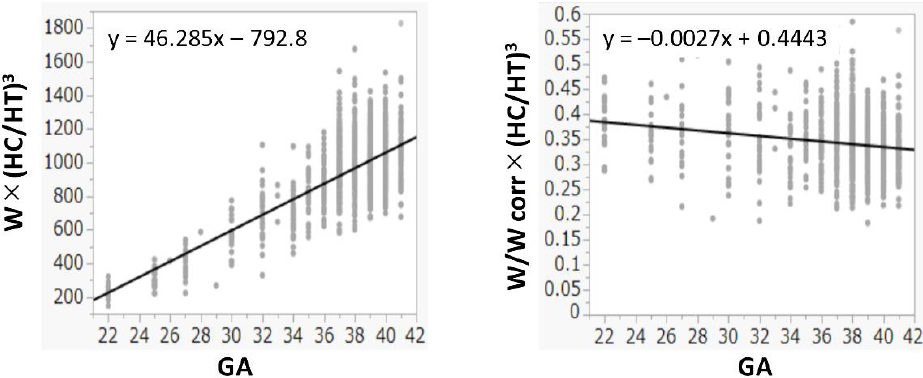
Figure 2. Physique index corrected by birth weight or birth weight corrected by mean weight for gestational age at birth. GA: gestational age at birth; HC: head circumference; HT: height; W: birth weight; Wcorr: mean weight for gestational age at birth.